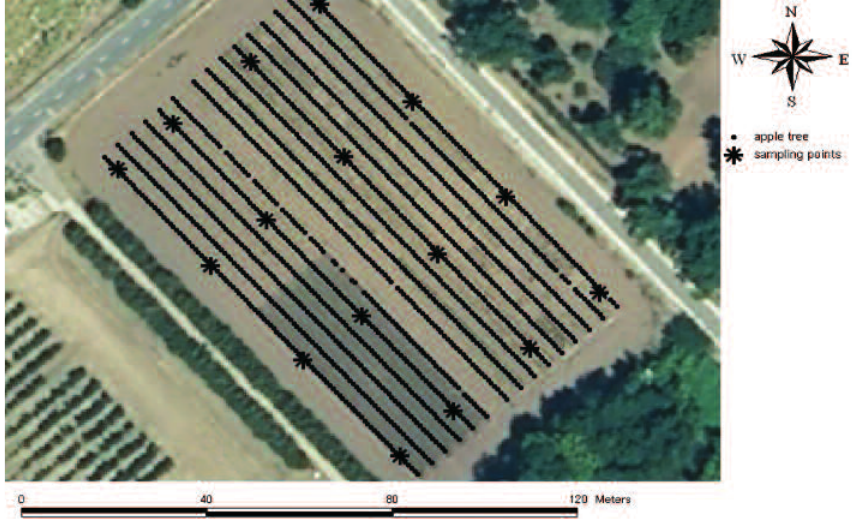
Figure 1: Research field and the sampling